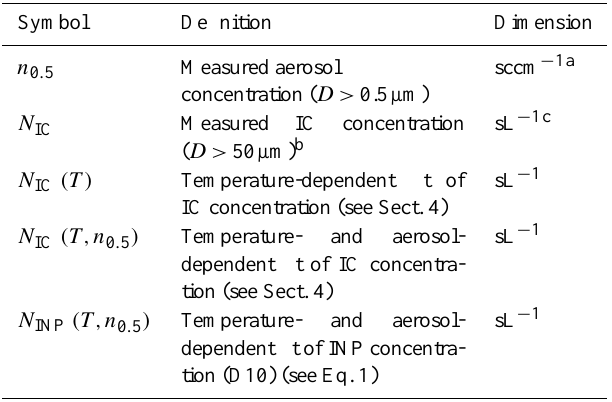
Table 1. Symbols used to represent aerosol, INP, and IC concentra-